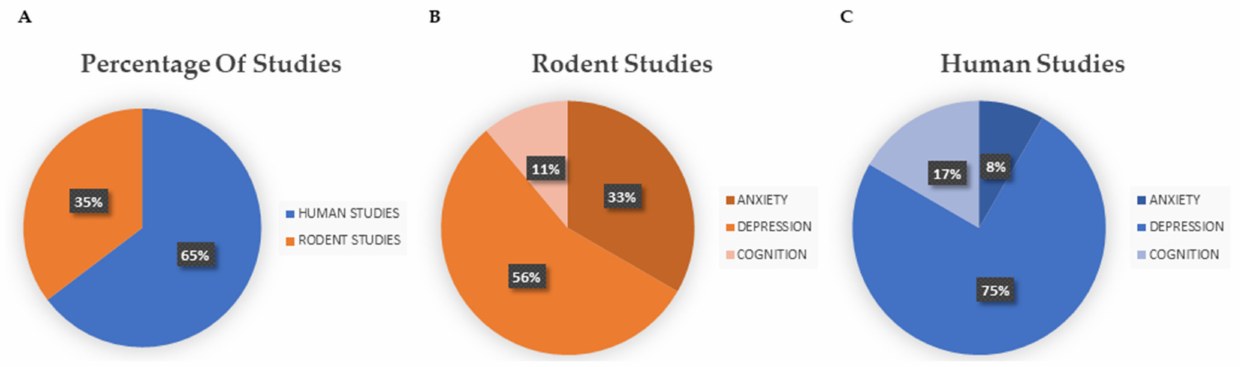
Figure 3. ( A ) Percentages of human and rodent studies included in this systematic review (six rodent and eleven human studies); ( B ) percentage of rodent studies divided by main topic (three studies on anxiety and depression, two studies on depression alone, and one study on cognition); ( C ) percentage of human studies divided by main topic (one study on anxiety and depression, eight studies on depression alone, and two studies on